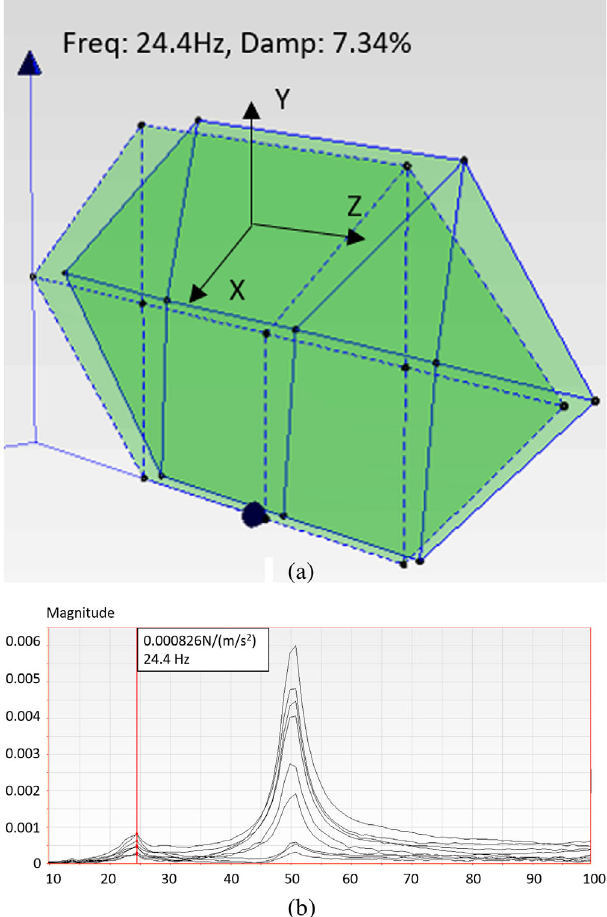
FIG. 6. Tested results of case 2: (a) the first-order mode shape and (b) the transfer function of X-direction vibration.